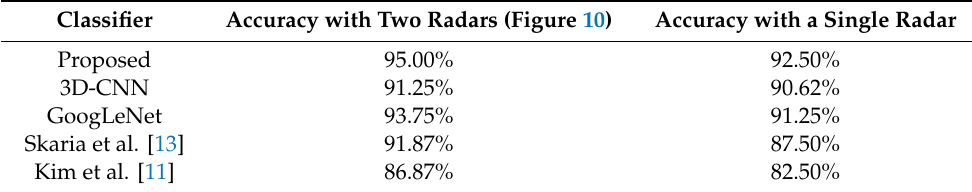
Table 4. Accuracy comparison of the proposed technique with the